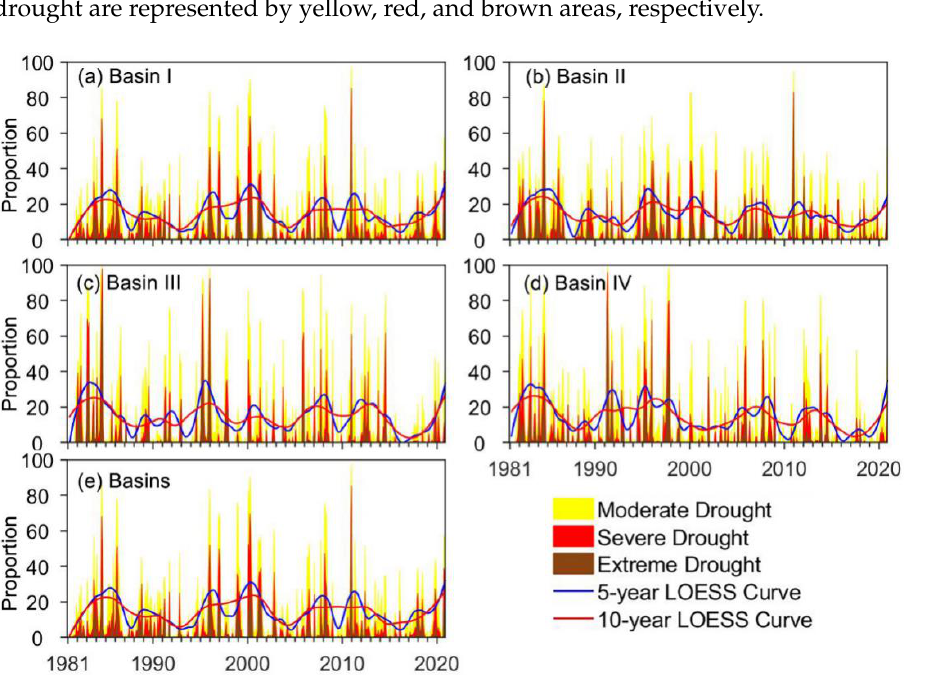
Figure 9. Temporal evolution of drought areas in the study area and each basin.